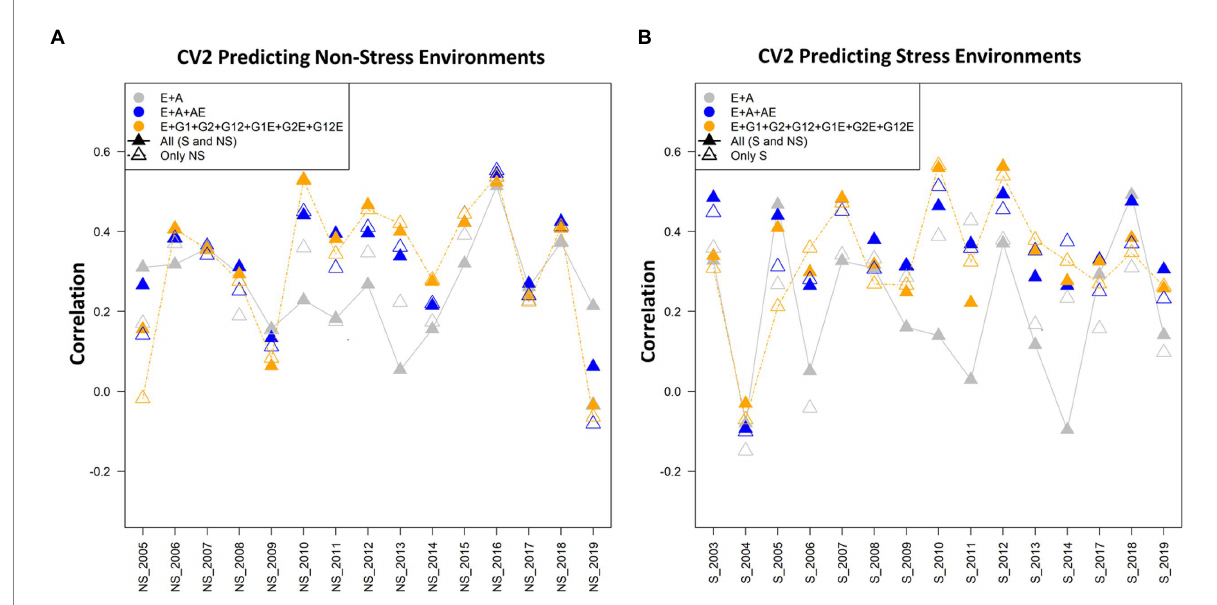
FIGURE 2 (A) The average correlation values obtained from predicting the grain yield for incomplete trials (CV2) for non-stress conditions with the non- stress (NS) and combined [All (S and NS)] calibration datasets. The plot depicts the correlations between the predicted and estimated values across the years 2005–2019, using model 1 (E + A), 2 and 5, respectively. (B) The average correlation values obtained from predicting the grain yield for incomplete trials (CV2) under the stress conditions using the stress (S) and combined [All (S and NS)] calibration datasets. The plot depicts the correlations between the predicted and estimated values across the years 2003–2019, using model 1 (E + A), 2 and 5,